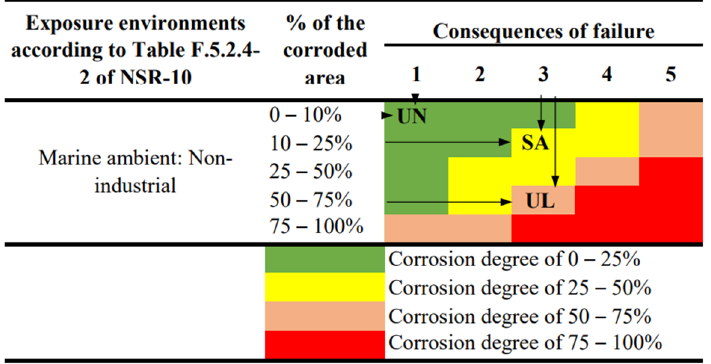
Figure 21. Evaluation of the corrosion degree. With UN: Uninorte, SA: Sagrado and UL: Unilibre.